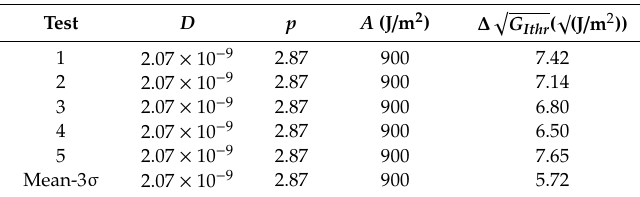
Table 4. Values of the constants employed to compute the da / dN versus G Imax relationships shown in Figure 8.